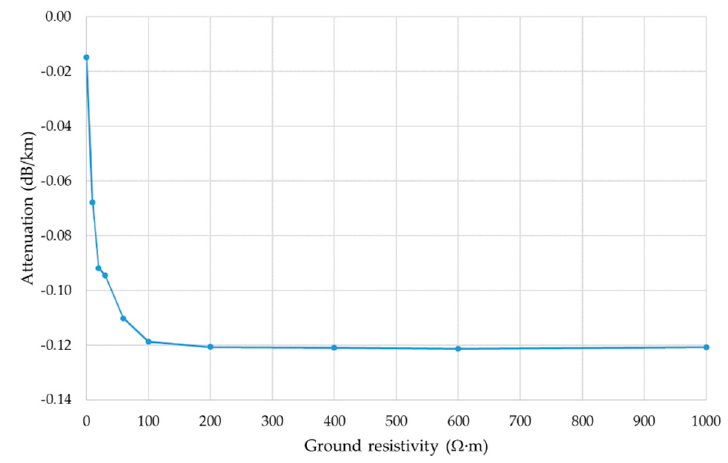
Figure 10. Attenuation variation versus ground resistivity.